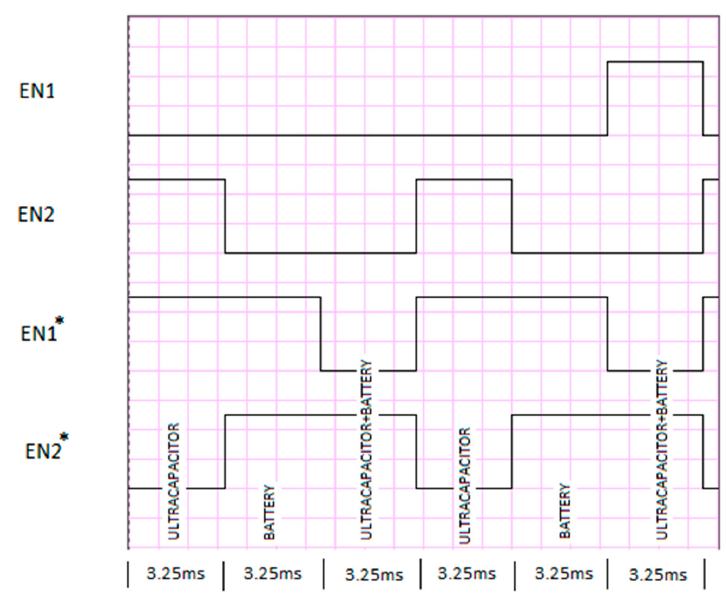
Figure 27. Mode control using the buffer.